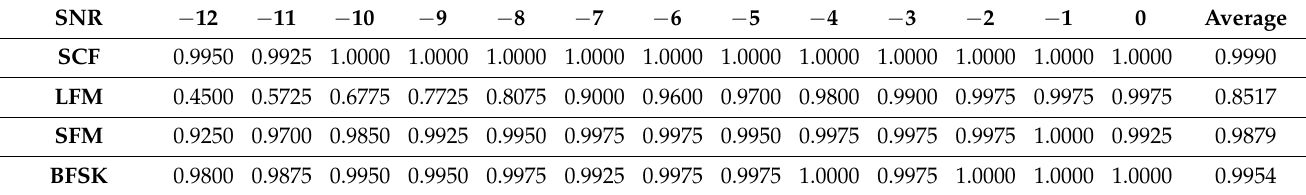
Table A2. The fully supervised classification results with the datasets in Situation Dataset